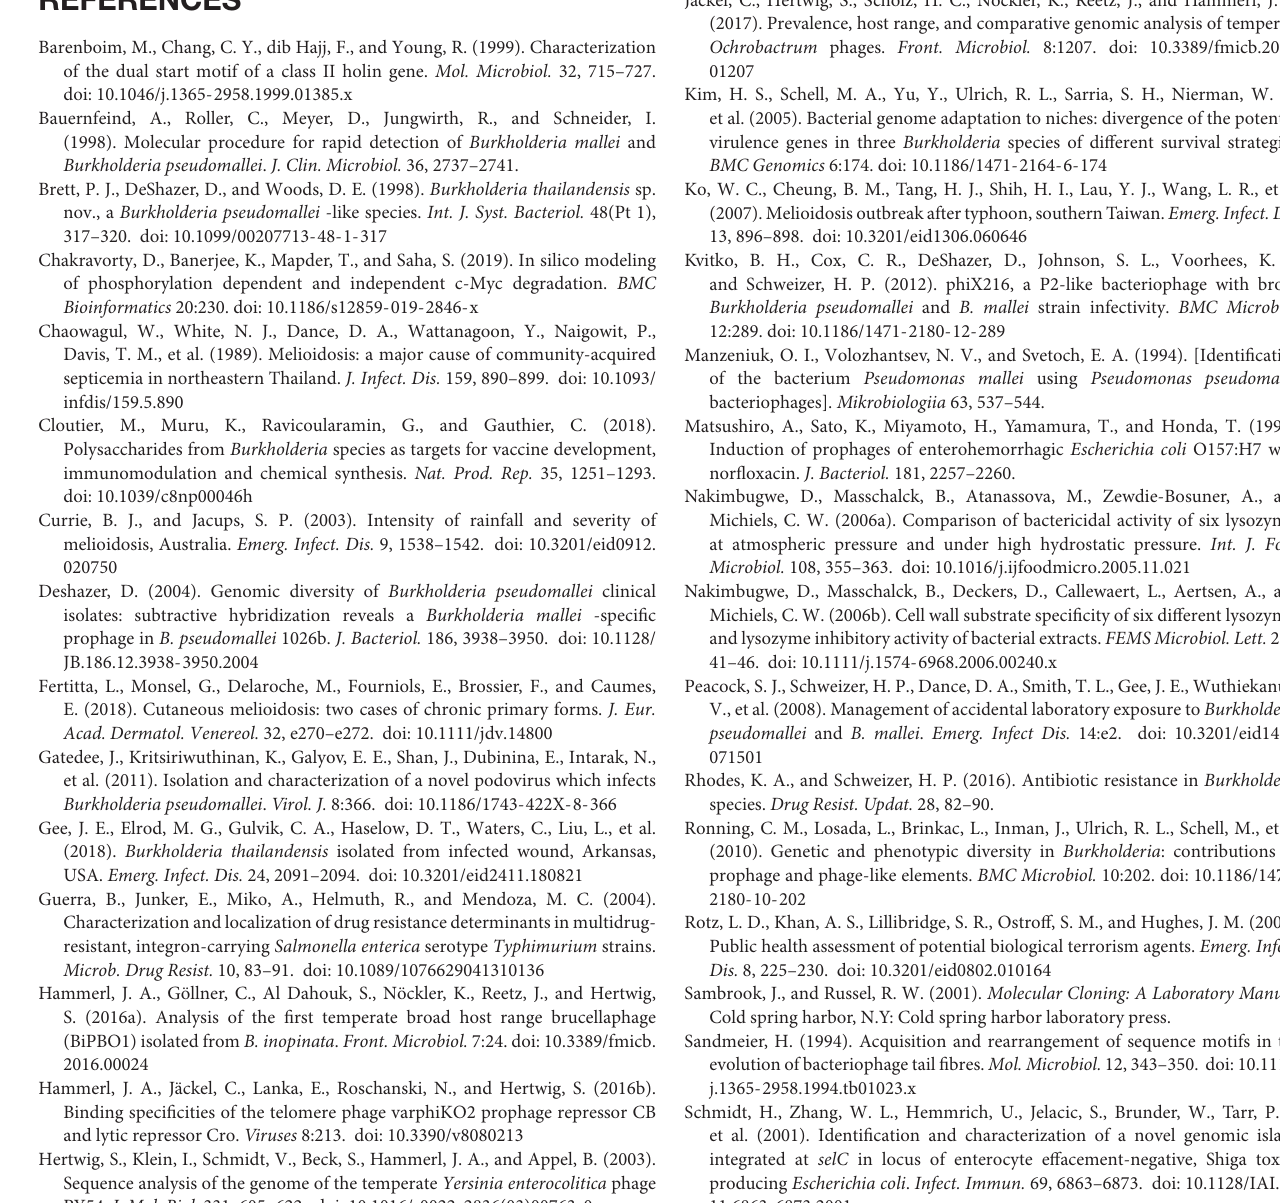
FIGURE S3 | Nucleotide sequence relationship of Burkholderia phages. The relationship of the phages was calculated using a similarity value of 85%. Sequence comparisons were conducted using DS Gene (Version 2.5, Accelrys Inc.). FIGURE S4 | Degradation of control phage DNAs by Bal31 treatment. Bal31 digestions of the circularly permuted genome of di Ochrobactrum phage